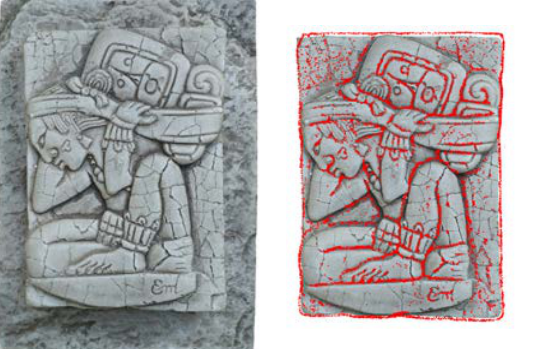
Figure 7. Photo of the test object (left) and the deep points of ScanArm model projected onto the photo (right)